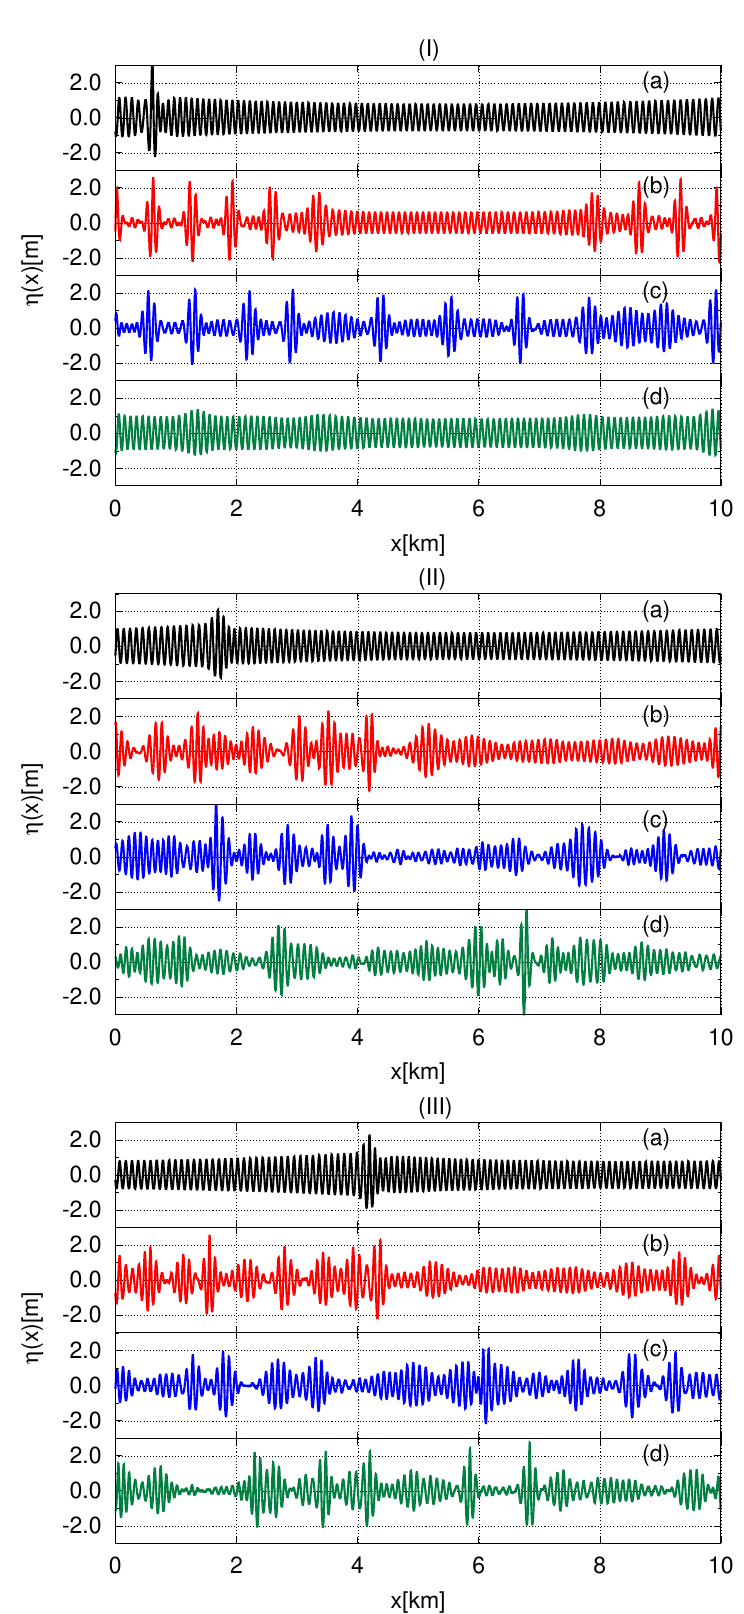
Figure 12. Snapshots of the free surface showing wave field evolution in different models at large times for µ = 0.04 and ˜ k p = 1. Figure ( I ) corresponds to the NLS equation, figure ( II ) to the SCZ equation, and figure ( III ) to the RV equations. In each subfigure the panels ( a ) show the moment of time t ≈ 2.8 h, while the panels ( b ), ( c ) and ( d ) correspond to the moments of time t ≈ 6.2 h, t ≈ 34.6 h and t ≈ 39